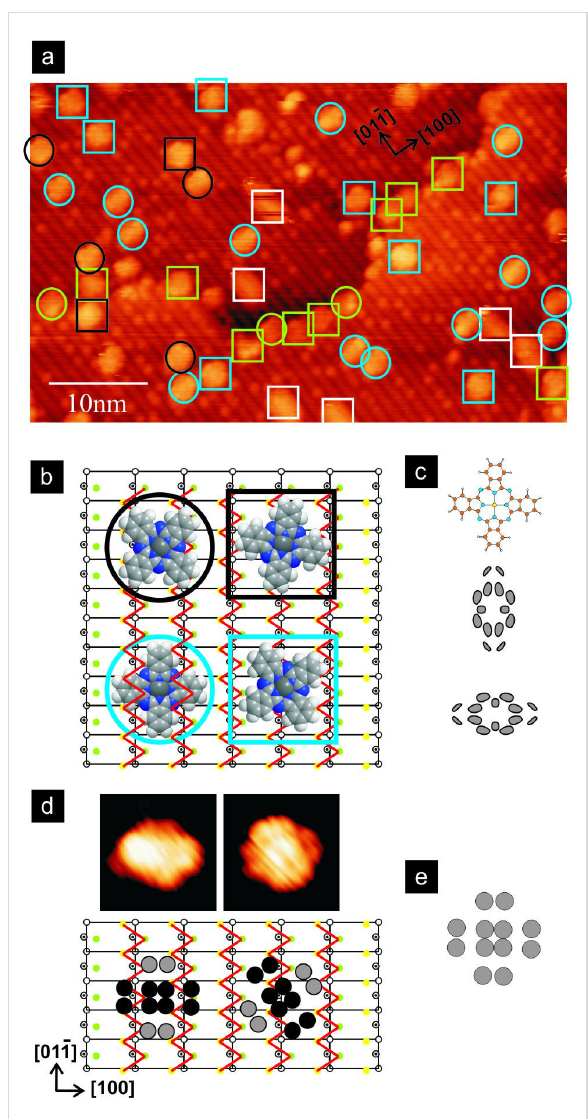
Figure 3: The adsorption geometries of CuPc molecules on the TiO 2 (011) substrate (coverage: 0.06 ML): (a) a submolecularly resolved empty-state STM image, (the squares are molecules adsorbed on oxygen zigzag rows, and the circles are molecules adsorbed in between the zigzag rows), (b) a schematic illustration of stable adsorption geometries on terraces, (c) a schematic image of a CuPc molecule and two orbitals forming the LUMO, (d) STM images of molecules exhibiting two-fold symmetry and their schematic illustration, (e) a schematic illustration of the STM appearance of a CuPc mole- cule. All scans: bias voltage 2.0 V, tunnelling current 2 pA. Colour coding: white – mobile molecules, green – molecules located at the step edges, black and blue – different azimuthal angle of the mole- cules. The figure has been adapted with permission from [33], copy- right 2011 AIP Publishing LLC.